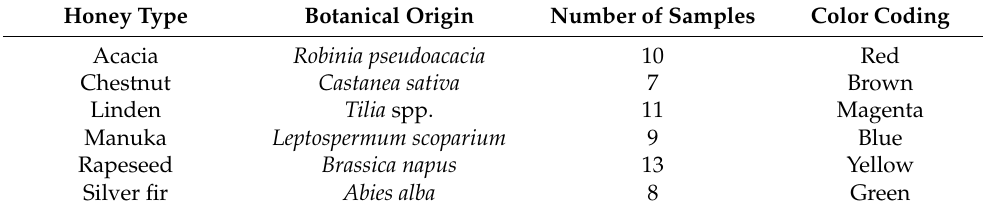
Table 2. Summary of the analyzed honey samples, differentiated by their type of botanical origin. Honey Type Botanical Origin Number of Samples Color Coding Acacia Robinia pseudoacacia 10 Red Chestnut Castanea sativa 7 Brown Linden Tilia spp. 11 Magenta Manuka Leptospermum scoparium 9 Blue Rapeseed Brassica napus 13 Yellow Silver fir Abies alba 8